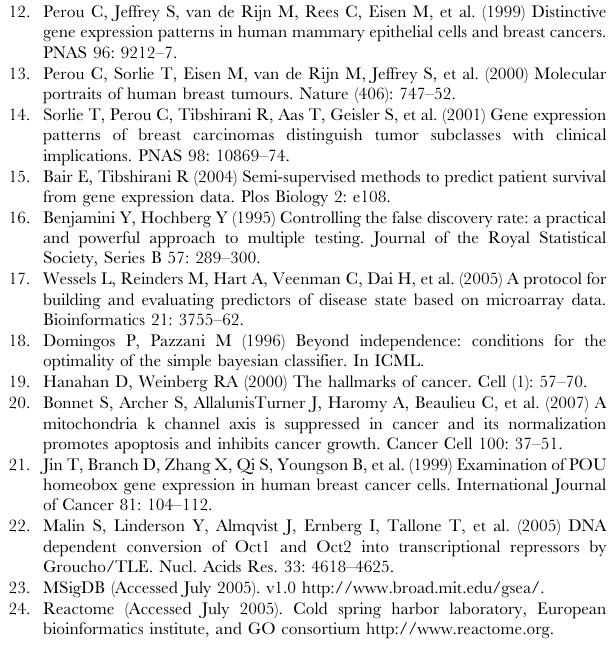
Found at: doi:10.1371/journal.pone.0001047.s007 (0.03 MB DOC) Found at: doi:10.1371/journal.pone.0001047.s008 (0.03 MB